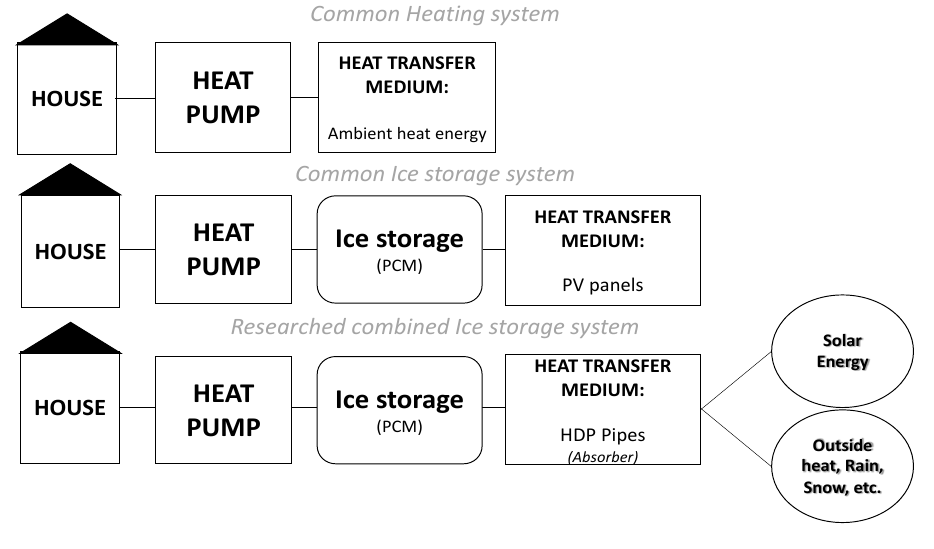
Figure 1. Heating systems comparison.